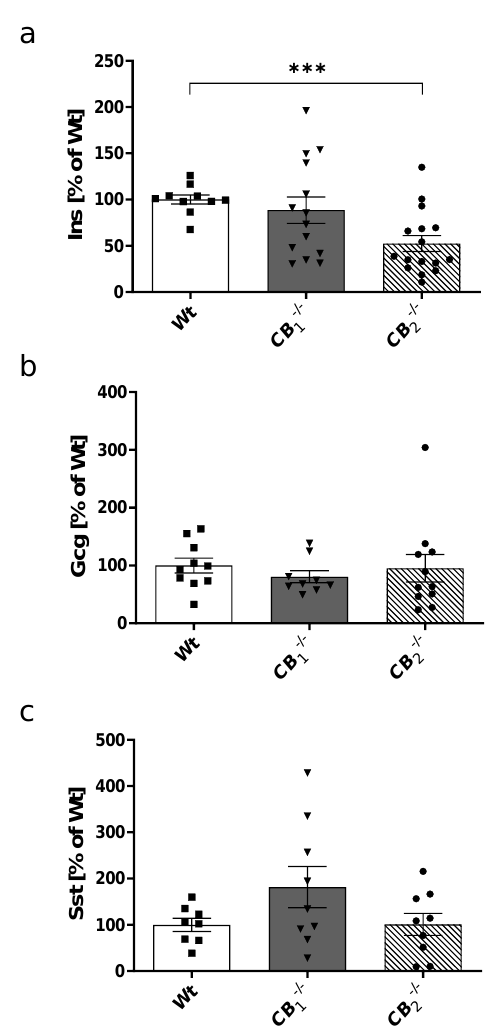
Figure 4. Western blot analysis of insulin ( a ), glucagon ( b ) and somatostatin ( c ) protein in pancreatic tissue of male and female wild-type (Wt) mice and cannabinoid receptor knockout mouse lines (CB 1 −/− , CB 2 −/− ). ( a ) Insulin protein was decreased in the pancreatic tissue of CB 2 −/− mice. ( b ) Glucagon and ( c ) Somatostatin protein content displayed no significant differences, although a nonsignificant increase in CB 1 −/− was observed. Values are presented as mean (± S.E.M.) with n = 8 – 16 mice per group. Each protein level of male and female Wt mice was defined as 100%. *** p < 0.001; unpaired t -test.